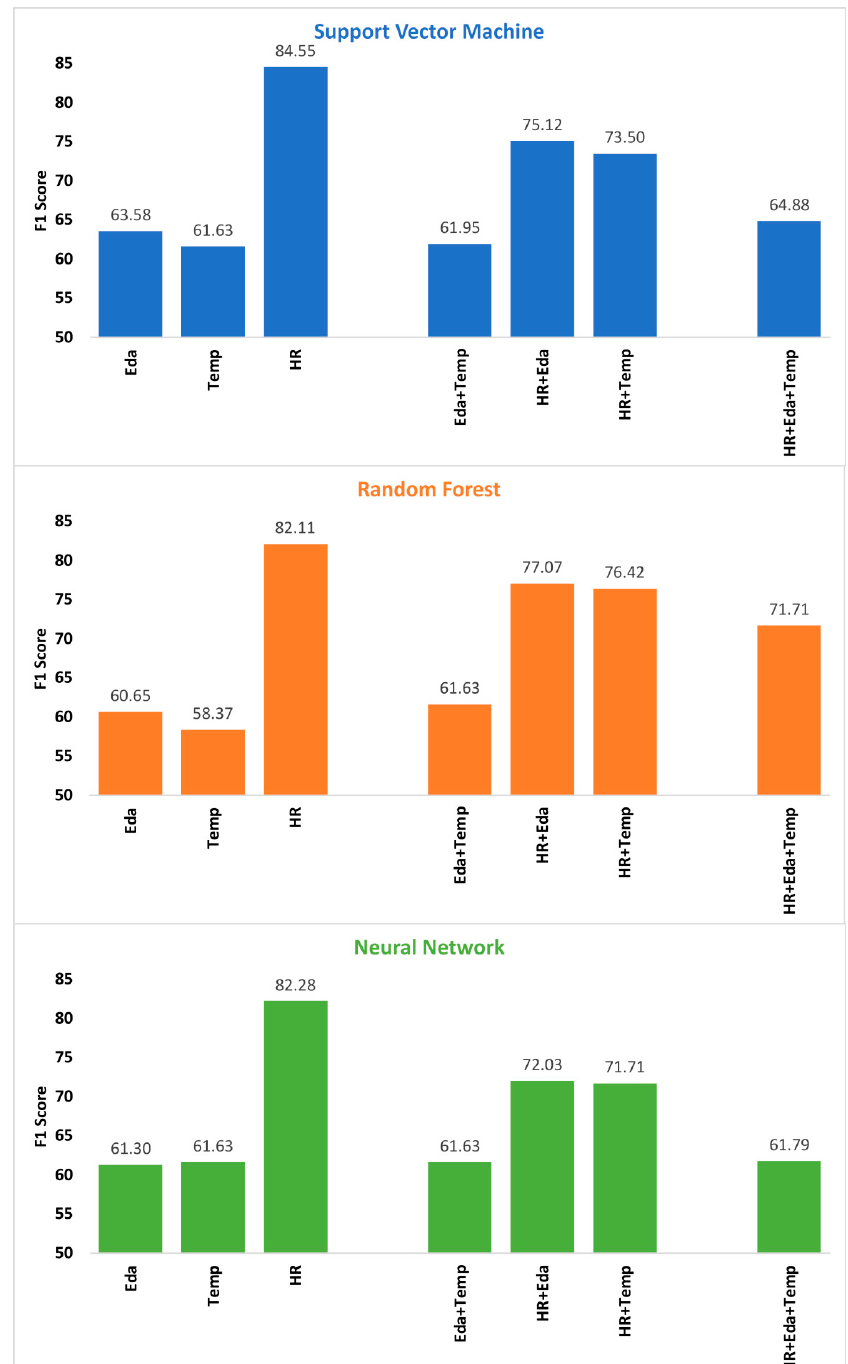
Figure 3. Scores for all combinations of modalities using decision fusion; Note: results of single modalities are also given as base-lines. Abbreviations: Eda = electrodermal activity; HR = heart-rate; Temp = temperature.